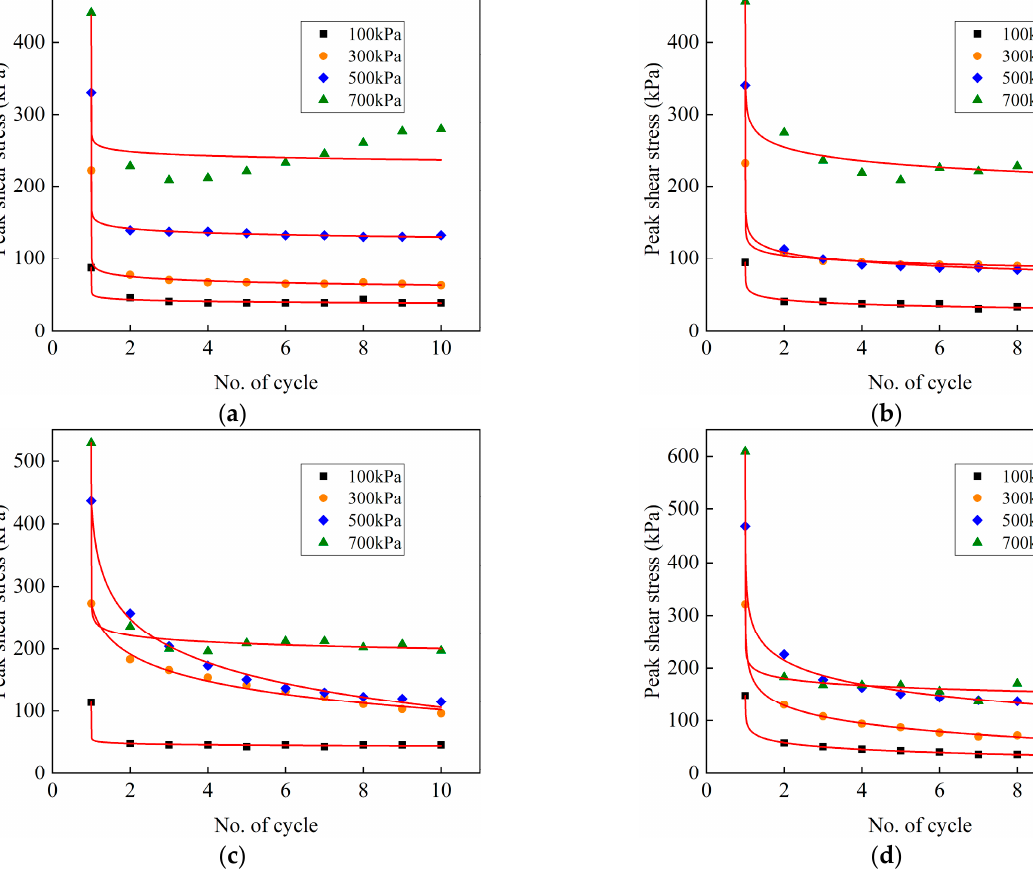
Figure 8. Fitting curves of the peak shear stress with the number of cycles under different normal stresses at − 4 °C– − 14 °C. ( a ) − 4 °C; ( b ) − 6 °C; ( c ) − 10 °C; ( d ) − 14 °C. Table 3. Parameters k 1 , k 2 , k 3 , and k 4 under different temperatures.